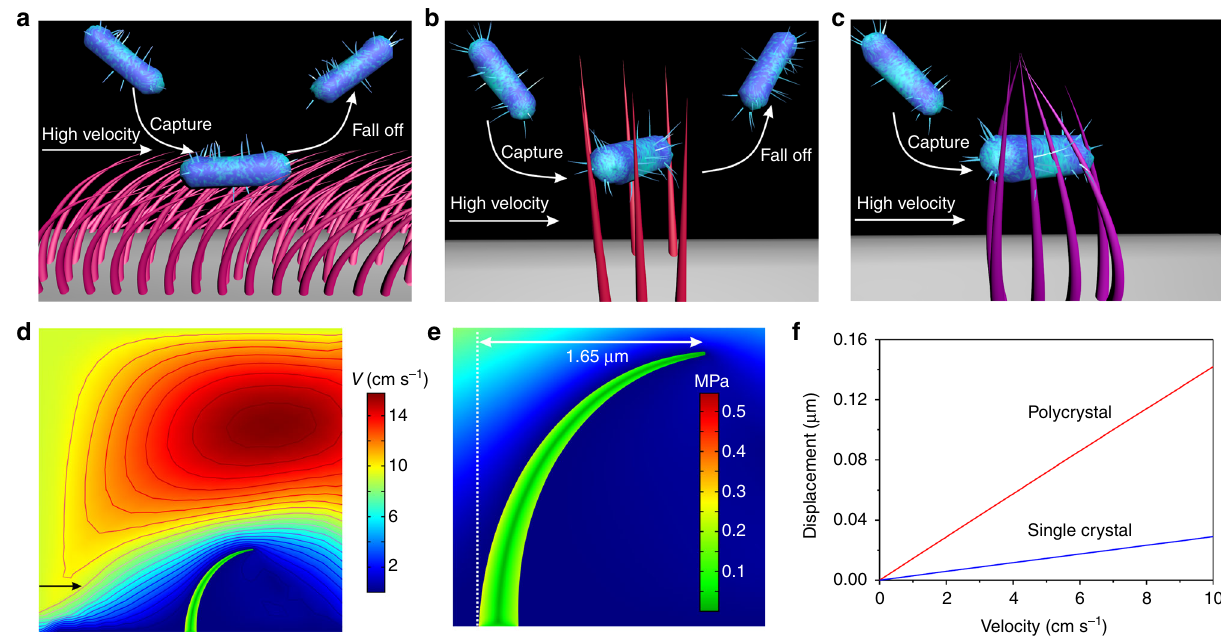
Fig. 3 Analysis of 3D nanoclaws formation conditions. a – c Three models of bacterial capture at high fl ow velocity depending on the E of the NWs. a The bacteria loaded on bending surface of soft NWs ( E < 1 GPa) will fall off readily. b Adsorbed bacteria can dynamically desorb from stiff NWs ( E > 2 GPa) surface as the shear force of the blood stream. c 3D nanoclaws generated by bendable moderate NWs (1 GPa < E < 2 GPa) prevent the immobilized bacteria from washing away at high fl ow velocity. d The fl ow fi eld around a single NW, wherein the arrow indicates the fl ow direction and the contour lines represent fl uid fl ow velocity of different levels. e The magni fi ed region of fl ow distribution illustrates that the von Mises stresses concentrate at the bottom of a single NW. The deformation of a NW ( E = 0.06 GPa) is 1.65 μ m at 10 cm s − 1 velocity. f Comparison of the deformation of single-crystalline